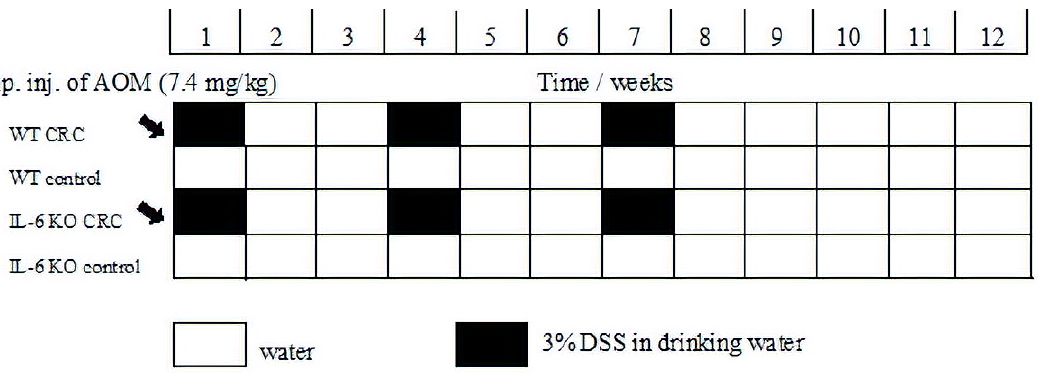
Figure 10. Timeline description of colorectal cancer induction using the AOM / DSS